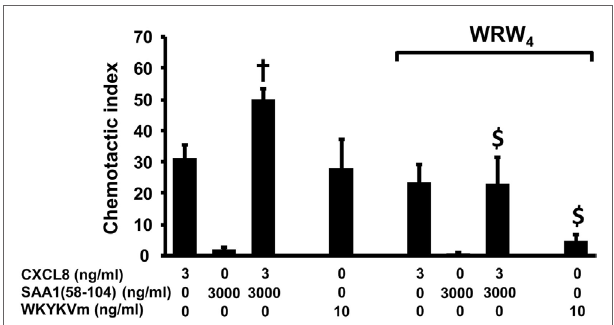
FigUre 8 | The selective formyl peptide receptor 2 antagonist WRW 4 blocks the cooperation between SAA1(58–104) and CXCL8 in neutrophil chemotaxis. WKYMVm (10 ng/ml), CXCL8 (3 ng/ml), SAA1(58–104) (3,000 ng/ml), or a combination of CXCL8 and SAA1(58–104) were added